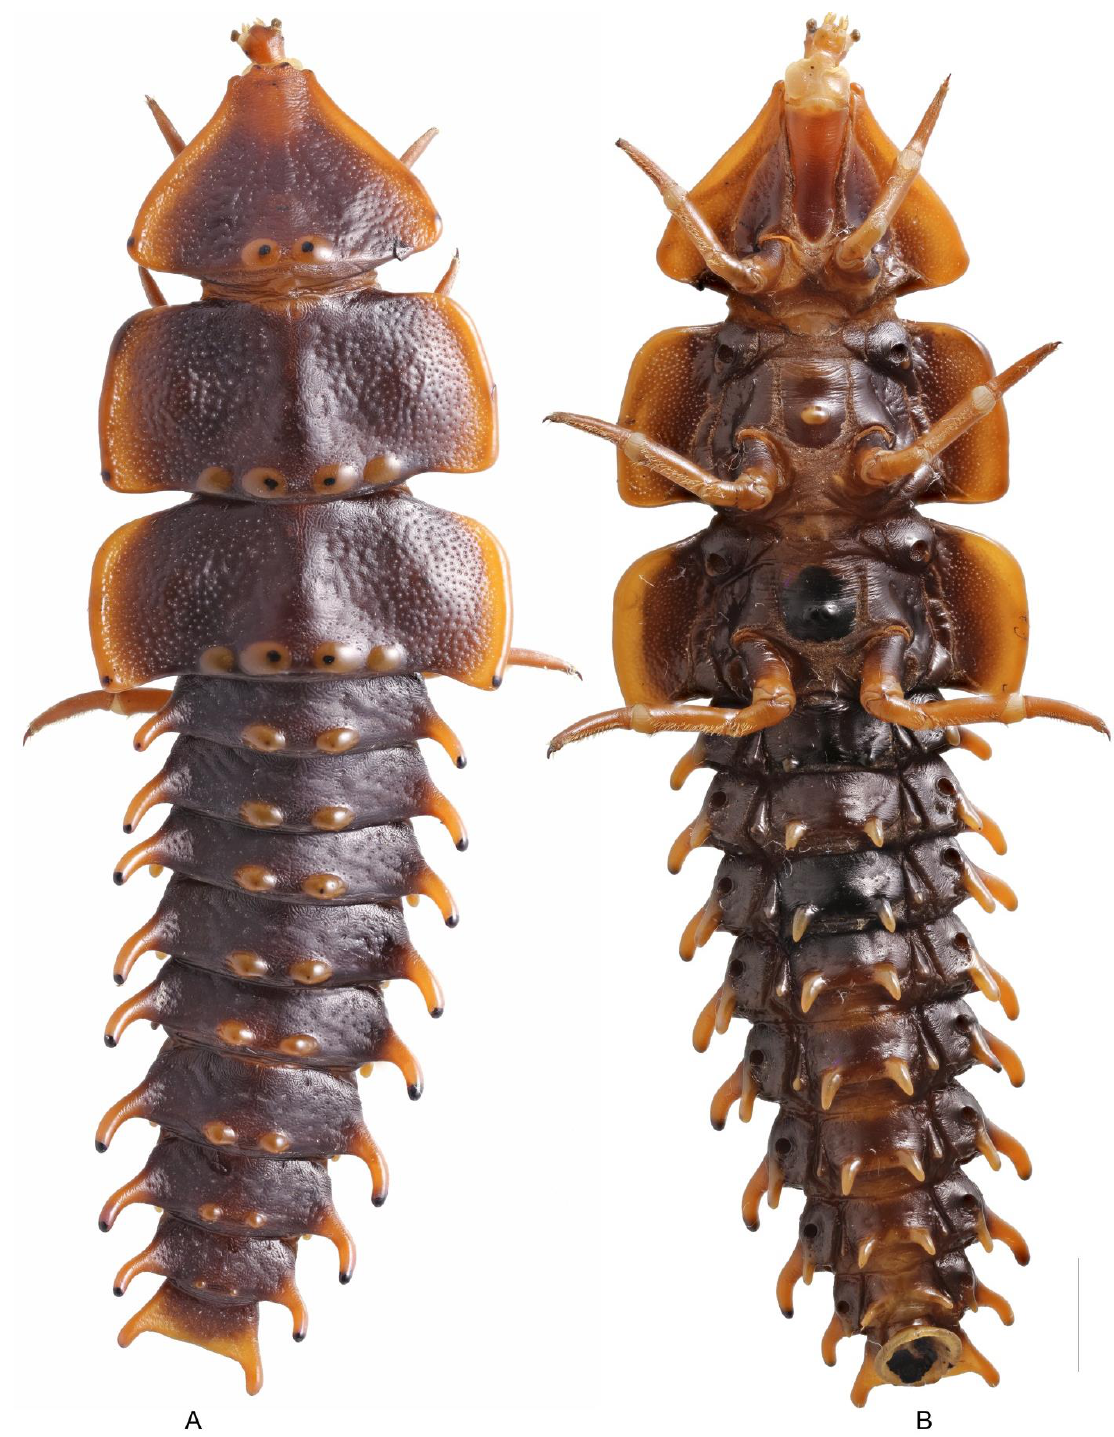
Figure 2. Platerodrilus svetae , female larva. ( A ) — general view, dorsally; ( B ) — same, ventrally. Scale bar — 5 mm.